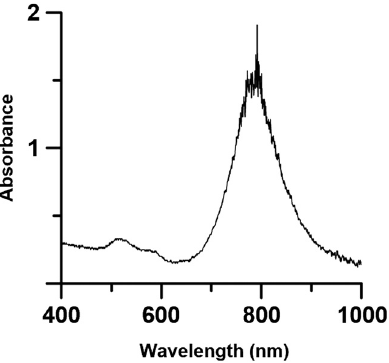
Figure 3: The UV - vis spectrum of AuNRs.